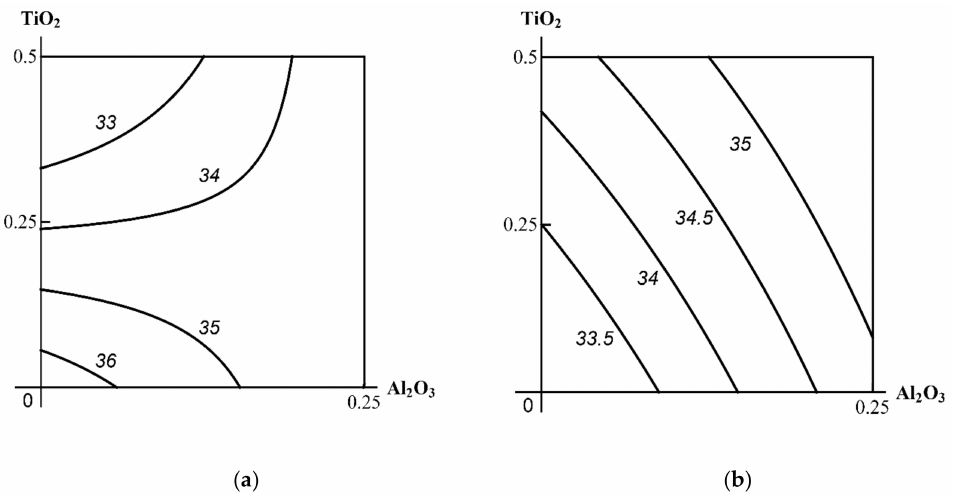
Figure 1. Examples of Class A three-factor toxicity: ( a ) antagonism or contradirectional effect of the Al 2 O 3 + TiO 2 combination (for different levels of effect and doses) on serum creatinine in the absence of a third agent changes (for all ratios of effects and doses) into ( b ) additivity in the presence of SiO 2 NPs. MeO NP doses on the axes are plotted in mg per rat. Numbers on the isoboles show effect values ( µ mol/L).